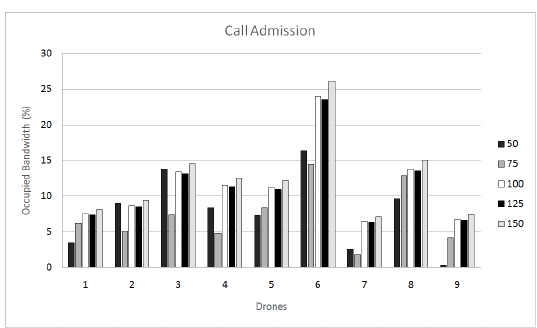
Figure 7. Curves on packets and requests number.